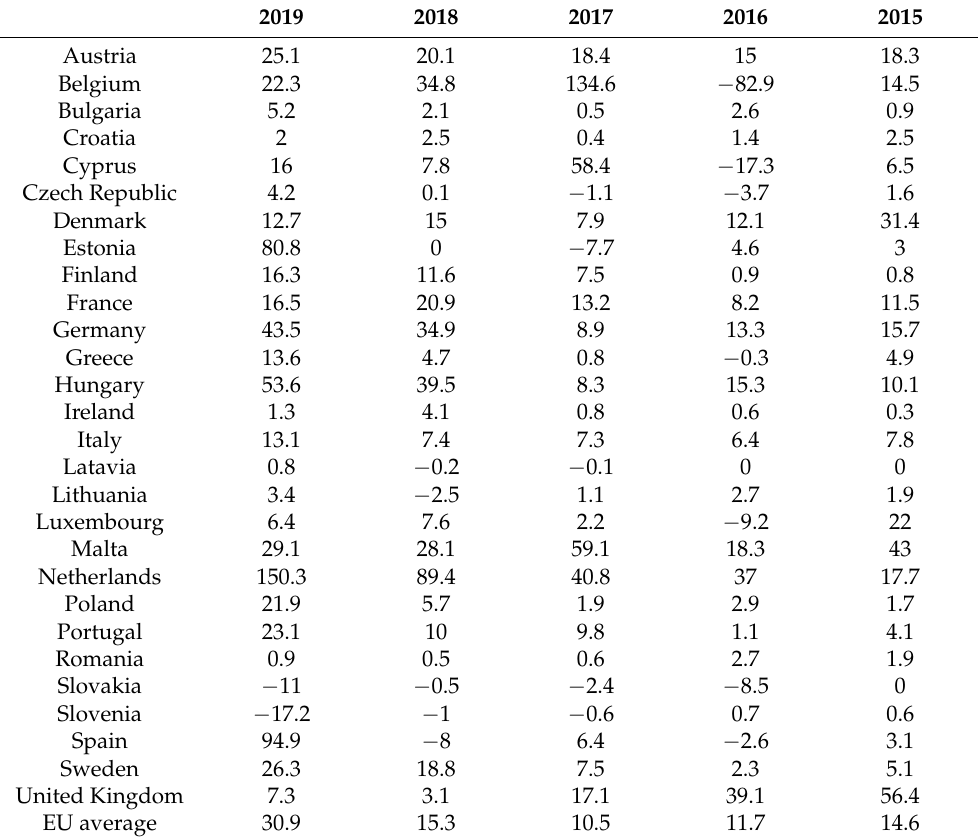
Table 8. Photovoltaic capacity installed in European Union Countries in years 2015–2019 per inhabi- tant (W/inhabitant).